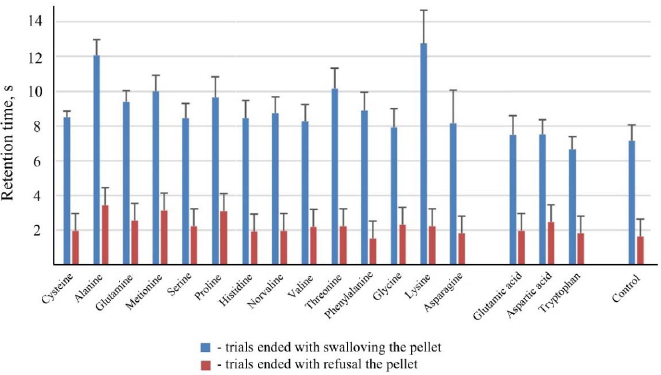
Figure 8. The number of grasps of pellets flavored with amino acids ended with swallowing or refusal of the pellet by barramundi Lates calcarifer . *, ** and ***—differences between trials per ‐ formed with each amino acid are significant at p < 0.05, p < 0.01, and p < 0.001, respectively (Mann– Whitney U ‐ test). Whiskers are the s.e.m.